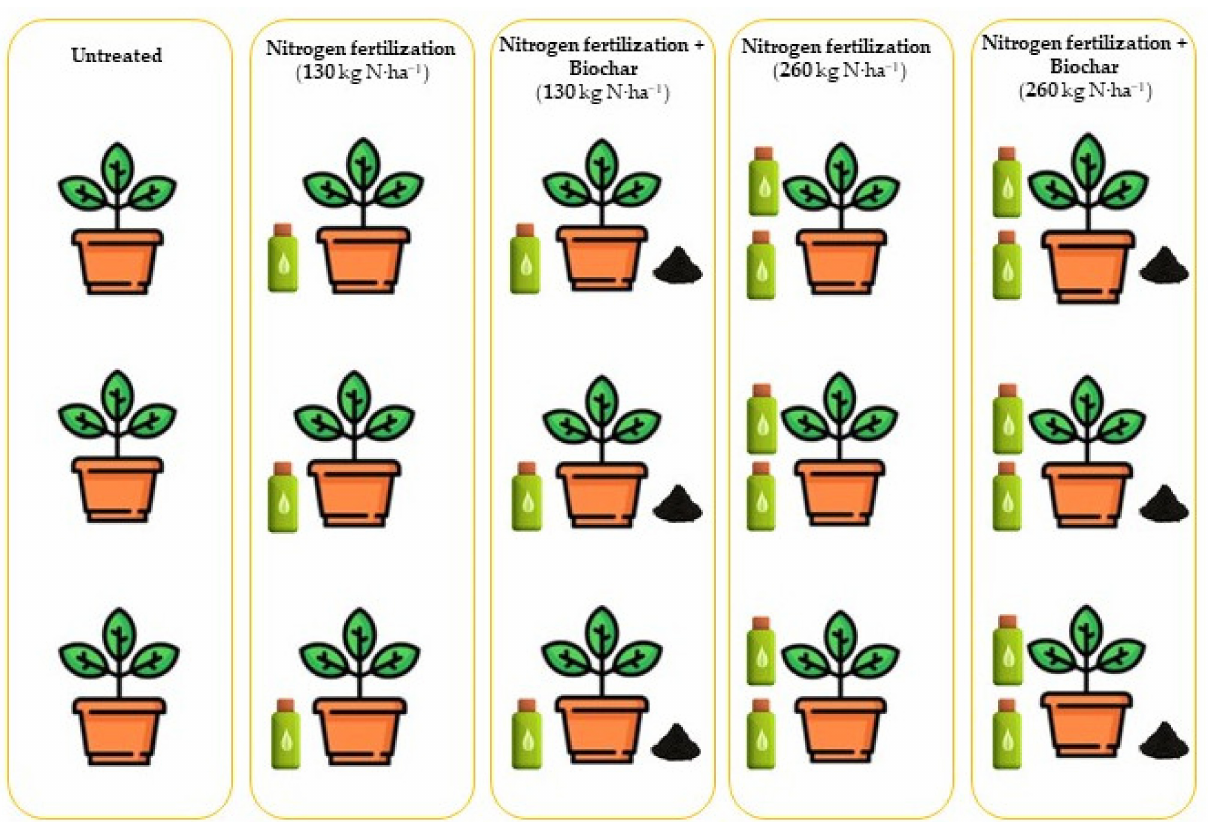
Figure 10. Experimental design showing the treatment